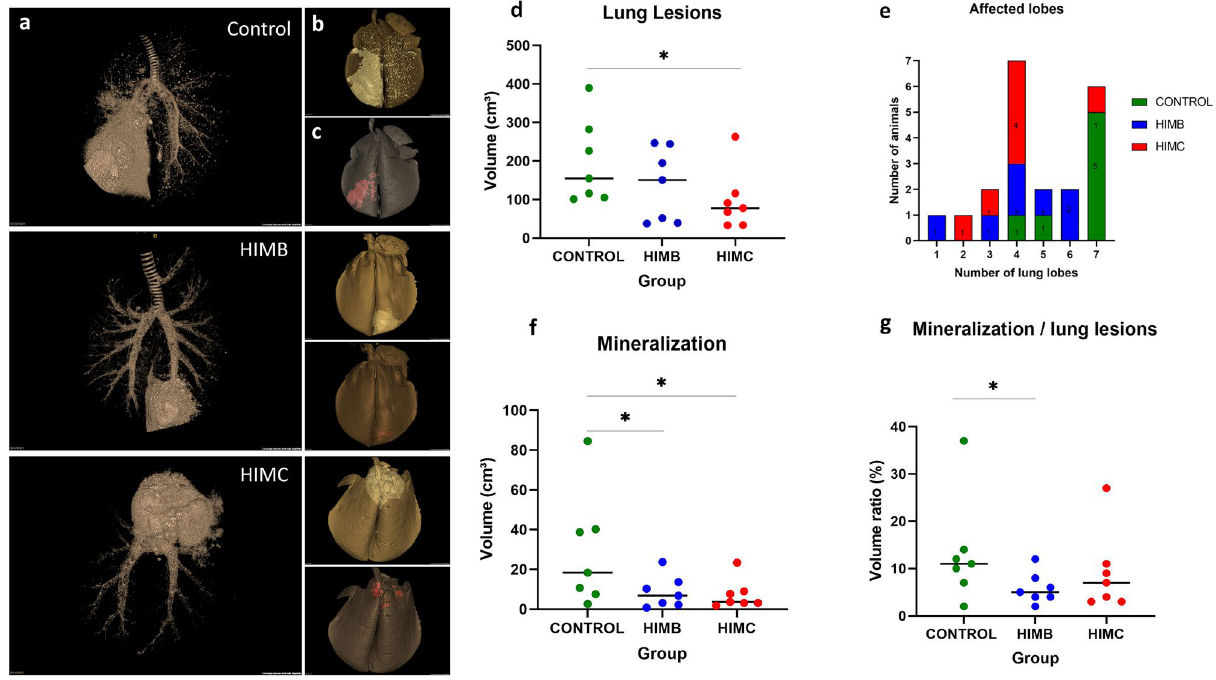
Figure 6. Lung pathology assessed by computed tomography (CT) of intratracheally formalin perfused lungs. Example of the images obtained from the lungs of an unvaccinated control and two animals vaccinated with HIMB and HIMC, respectively. ( a ) Larger images on the left show the tracheobronchial tree and the TB lesions. ( b ) The top right miniatures show the TB lesion (whitish) superimposed onto the lung volume (yellowish). ( c ) The bottom right miniatures show (in red) the mineralized portion of the TB lesion. ( d ) Volumes of lung TB lesions in each group expressed in cm 3 . ( e ) To evaluate the lesion dispersion within the lungs in each group, the number of lobes with TB lesions in each animal is plotted against the number of animals. The control group has a higher number of animals with a higher number of affected lobes than the vaccinated groups. ( f ) Volume of lesion mineralization expressed in cm 3 . ( g ) Ratio between the volume of mineralization and the volume of lung lesions expressed in %. Horizontal lines in ( d ), ( f ) and ( g ) represent the median values. Groups: Control (n = 7, green), HIMB (n = 7, blue), HIMC (n = 7, red). * P < 0.05, ** P < 0.01, Kruskal–Wallis test followed by one-tailed Dunn’s test for multiple